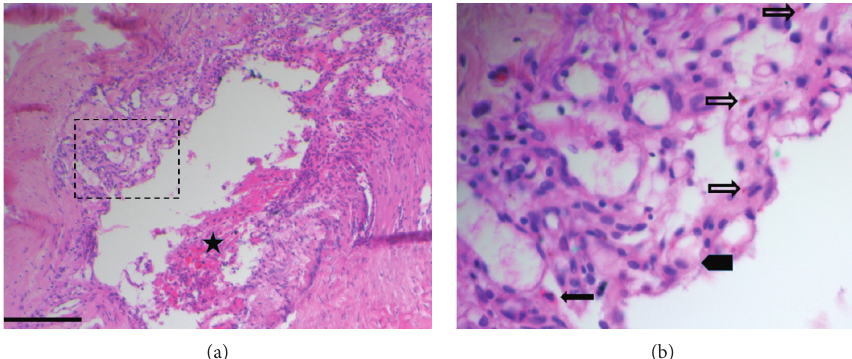
Figure 3: Histopathology of the excised dura with lymphocytic inflammatory remnants around a damaged venous sinus (a). In the upper part of the vessel wall (see also insert (b)) there is granulation tissue with many newly formed capillaries, lymphocytes, macrophages (thick arrow), a few eosinophils (thin black arrow) and some iron debris (thin open arrow). (Haematoxylin-Eosin Staining, bar � 1mm; asterisk � peripheral